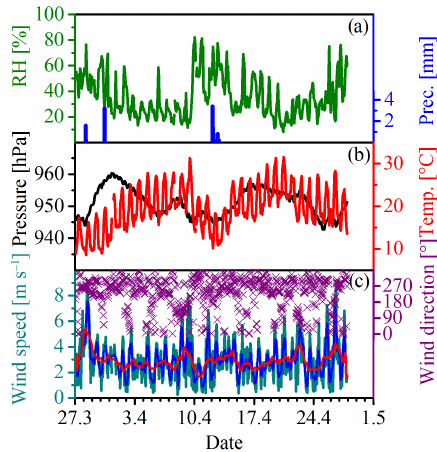
Figure 2. One-hour averages of meteorological parameters ( a rela- tive humidity (green) and precipitation (blue); b unreduced pressure (black) and temperature (red); c wind direction (purple crosses) and speed (cyan) and its running means of 6h (blue) and 24h (red)) dur- ing the campaign measured at CAO by the Department of Labour Inspection of Cyprus (DLI).